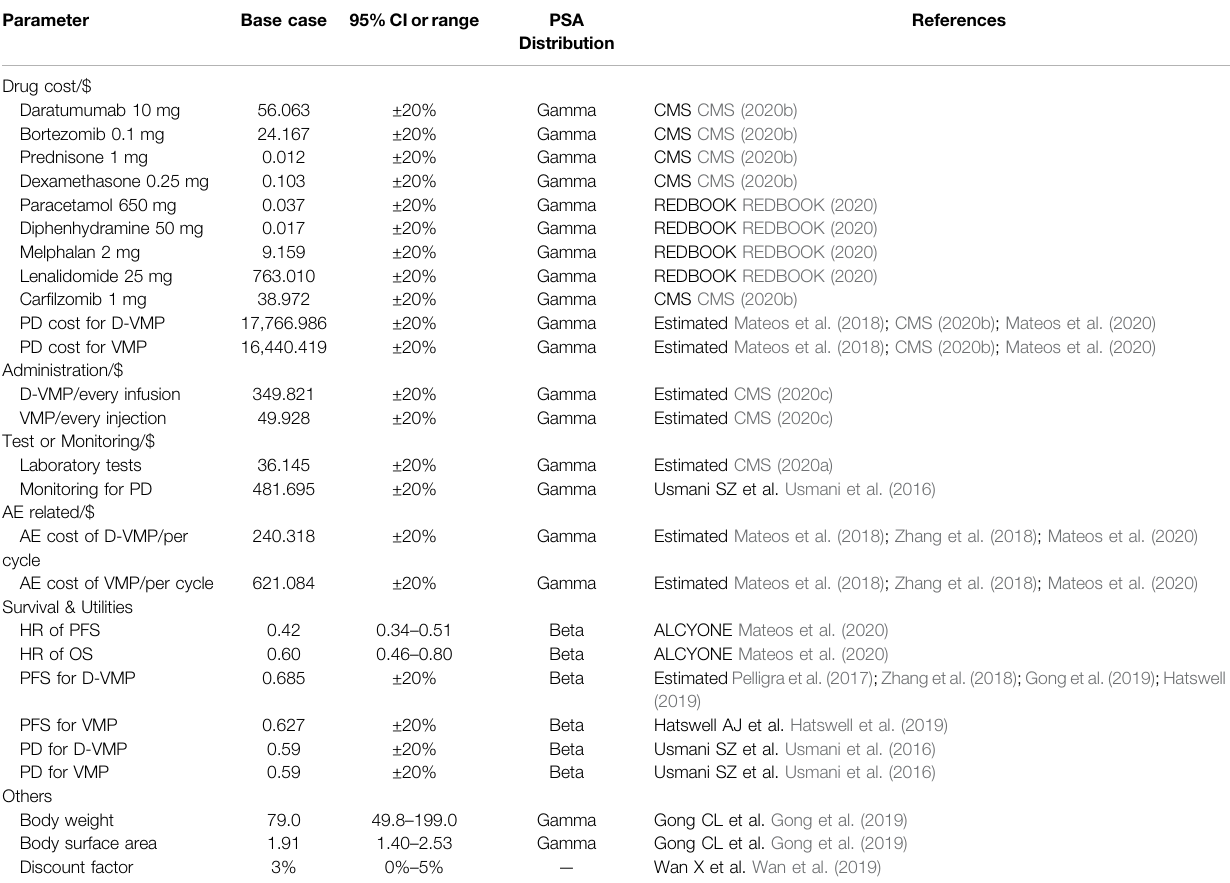
TABLE 1 | Key model parameters. Parameter